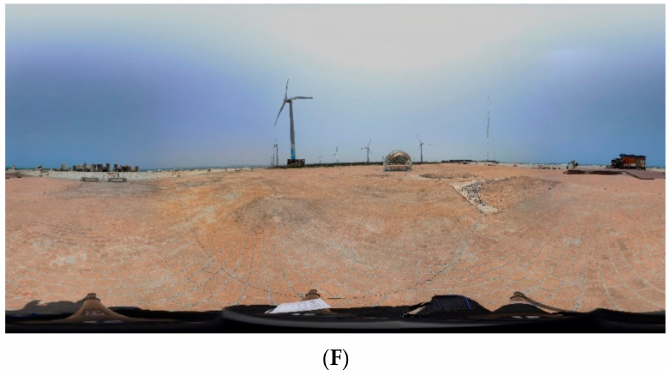
Figure 8. Stitched images station by station. ( A – F ) indicate Stations A to F, as shown in Figure 7.